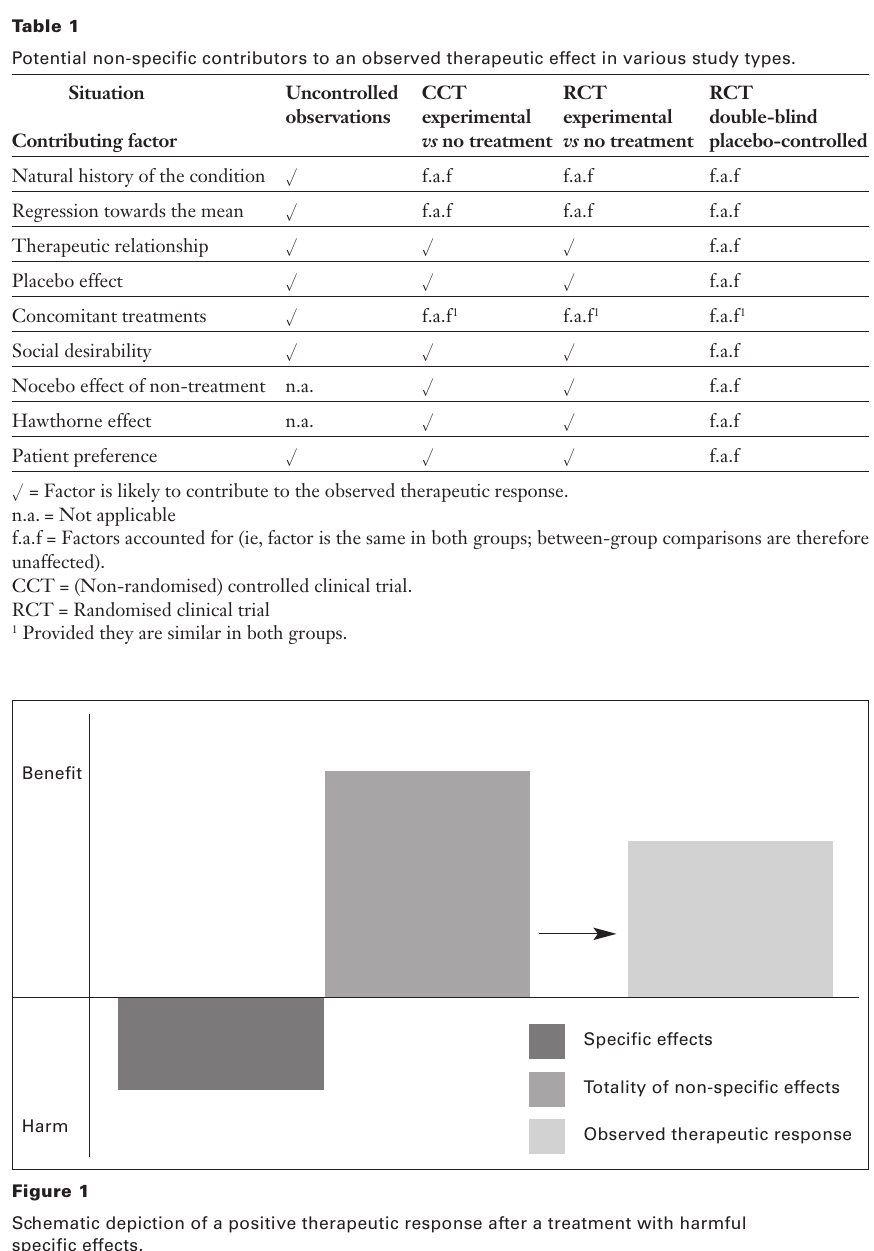
experimental double-blind